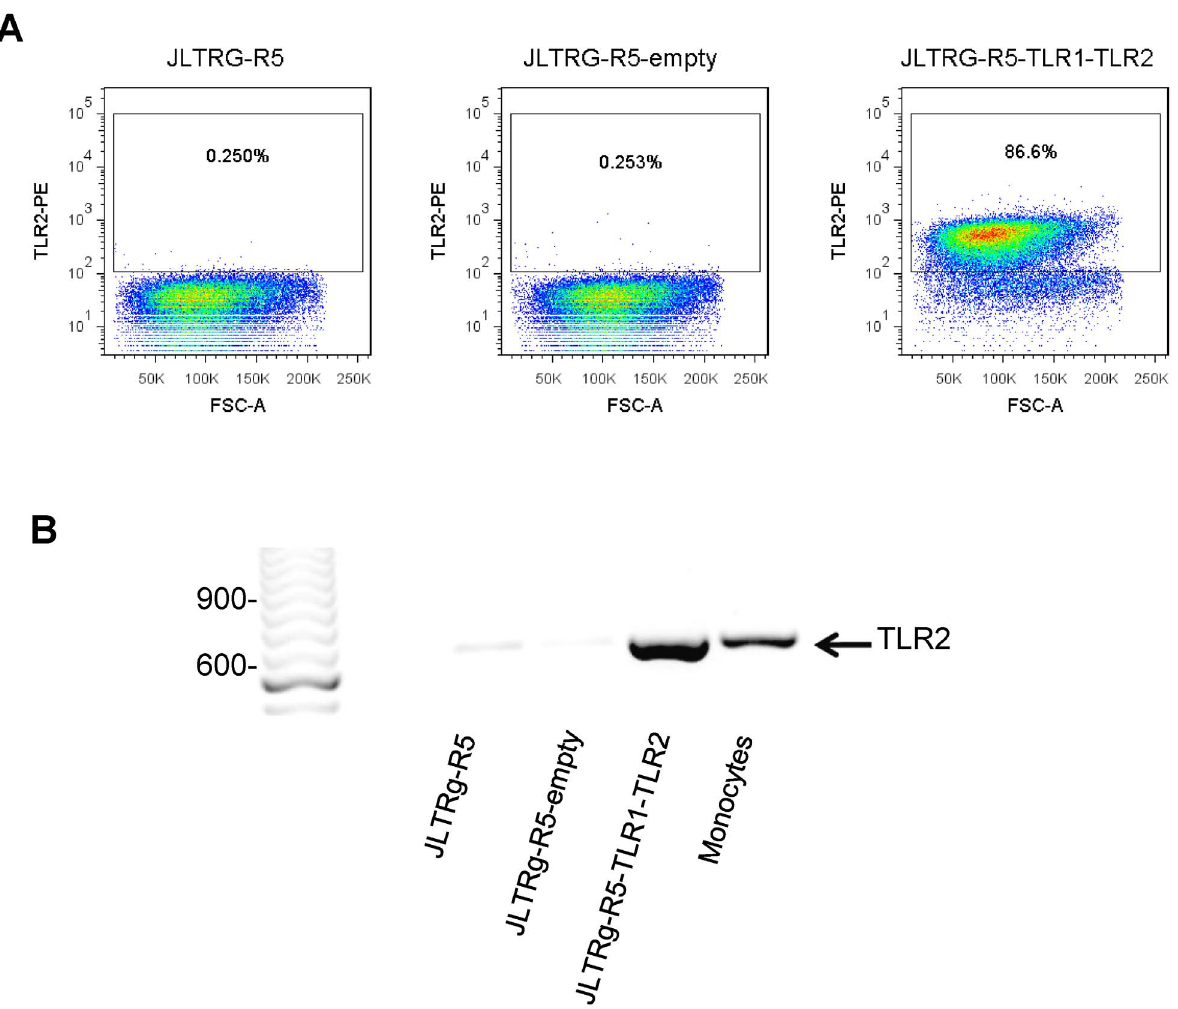
Figure 5. TLR2 expression on TLR1-TLR2 transfected Jurkat JLTRg-R5 T cells. (A) TLR2 protein expression on JLTRg-R5 cells before (JLTRg- R5) and after transfection with empty vector (JLTRg-R5-empty) or with vector encoding TLR2/1 (JLTRg-R5-TLR1-TLR2) was determined by flow cytometry. (B) Expression of TLR2 mRNA in JLTRg-R5 before (JLTRg-R5) and after transfection with empty vector (JLTRg-R5-empty) or with vector encoding TLR2/1 (JLTRg-R5-TLR1-TLR2) was measured by RT-PCR. Primary monocytes (MN) served as positive control. Shown is one representative experiment of three.